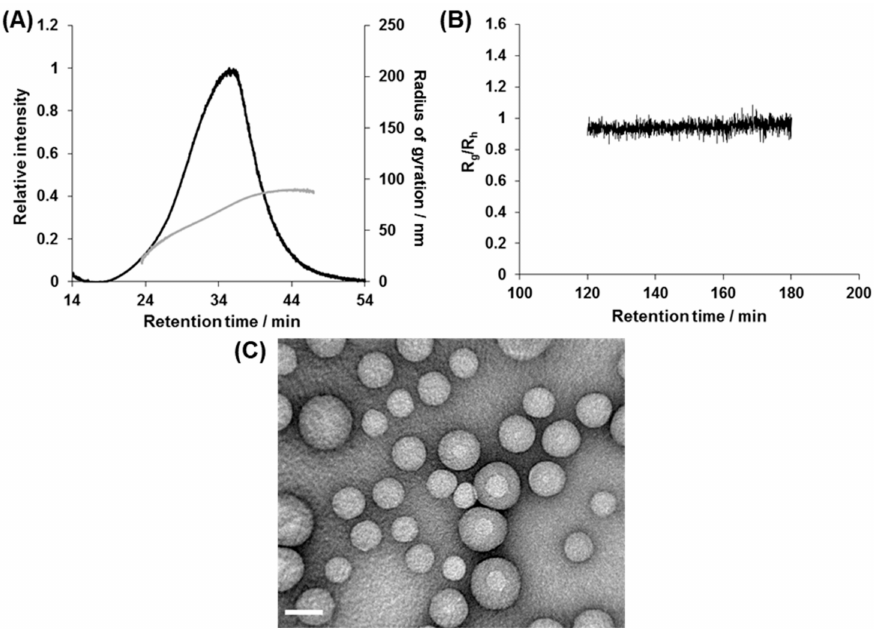
Figure 5. Structural characterization of as-prepared polymersome 1b . ( A ) AF4 fractogram, ( B ) Rg / Rh plot of 1b , and ( C ) TEM image. Scale bar: 100